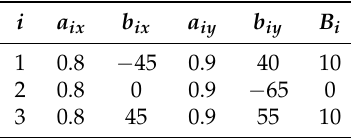
Table 2. Parameters used for the construction of a generated potential energy surface as shown in Figure